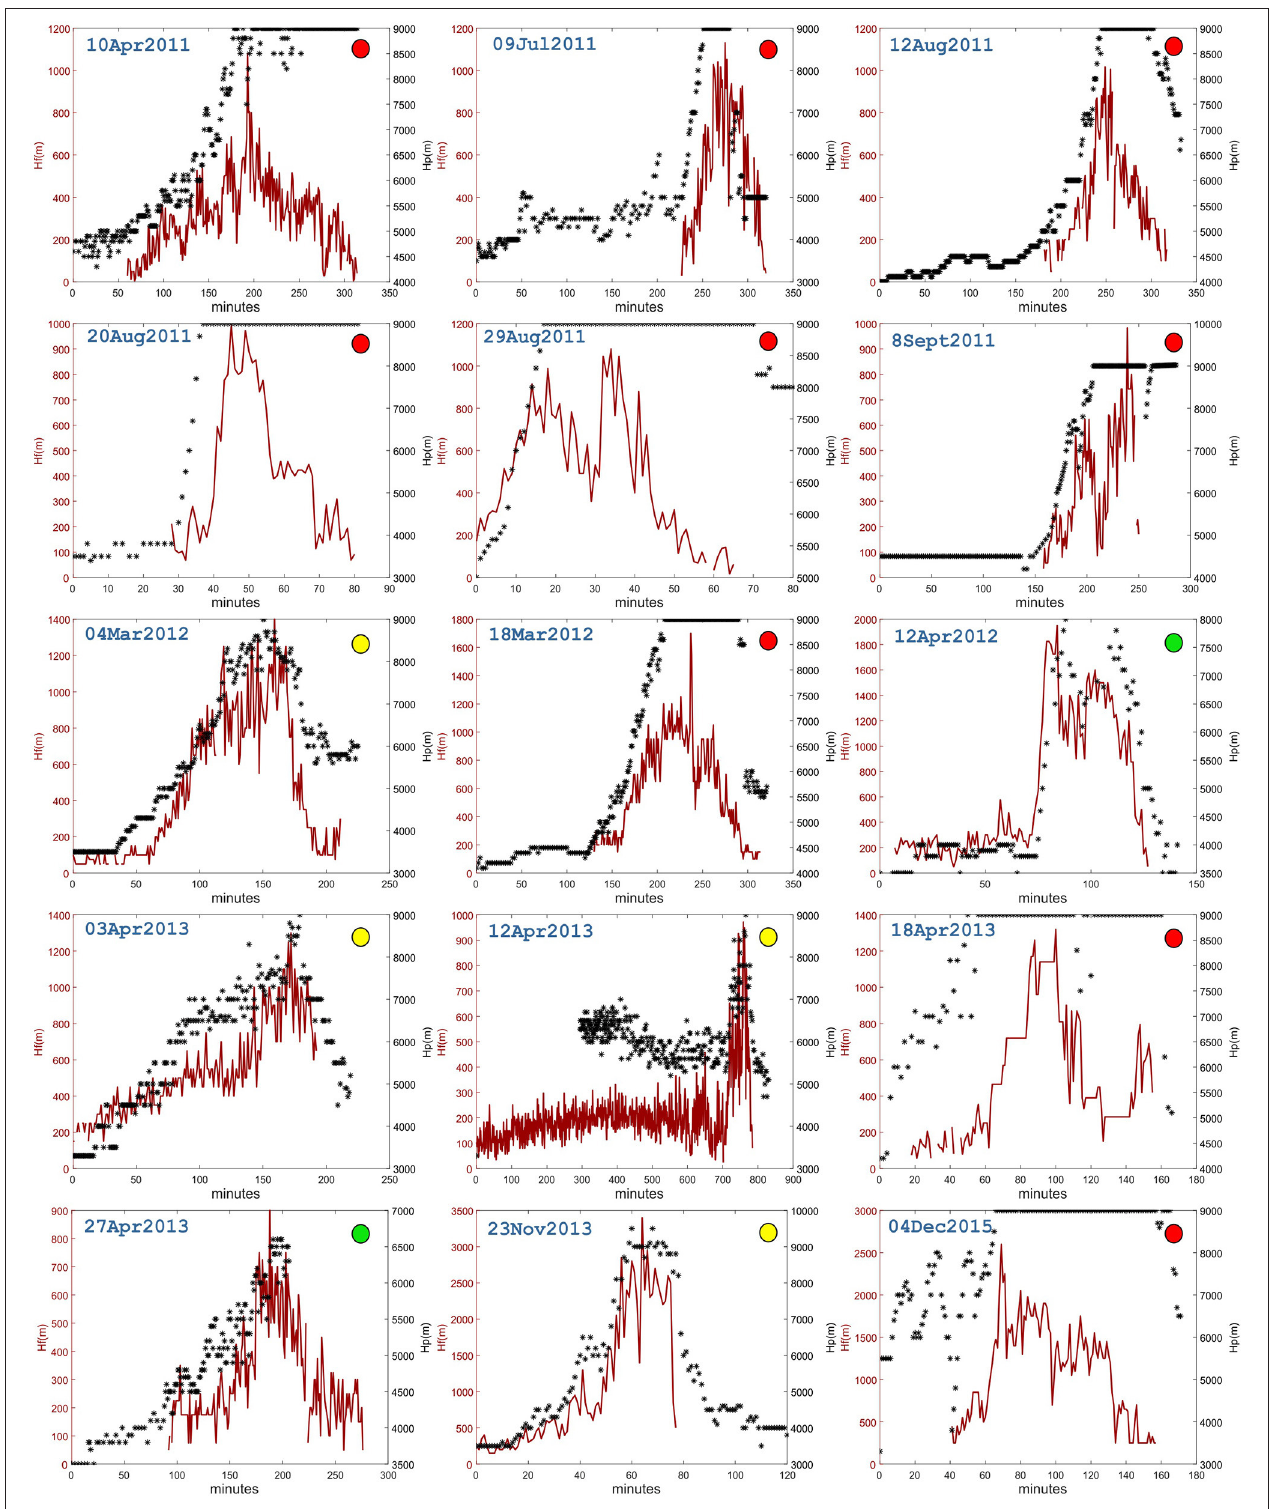
FIGURE 5 | Heights of the ash plume (black stars) measured up to the 9km a.s.l. limit of the field of view of the ECV camera (see Table 2 for details) and of the lava fountains (red line) for 15 episodes, with their plume classification (Strong plume with red circle, Intermediate plume with yellow circle and Weak plume with green circle; see also Figure 1 ), occurring during daytime and good weather conditions between 2011 and 2015. Note that the diagrams are not all on the same scale axes. The event of 27 April 2013 misses the final part of plume height (after the peak of the lava fountain) as it occurred at night.